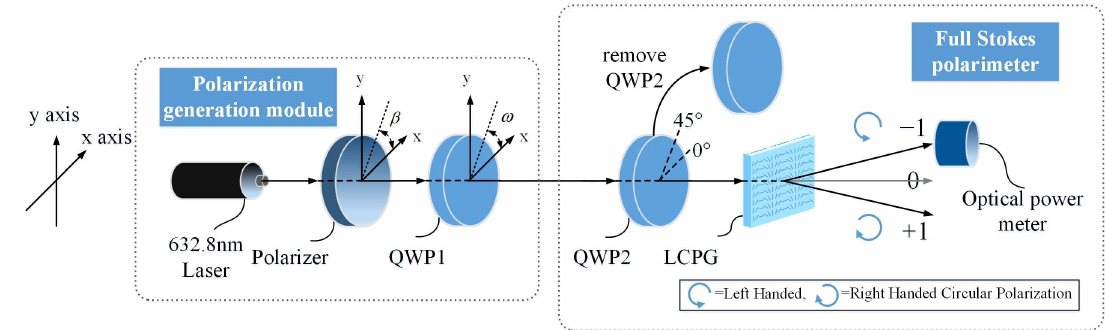
Figure 10. Configuration diagrams of full Stokes polarization detection.